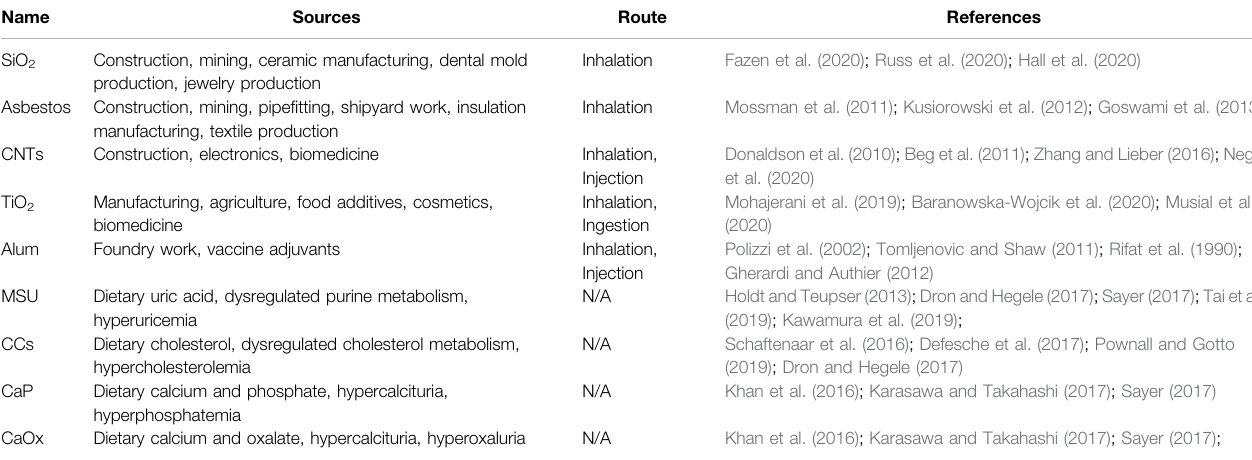
TABLE 1 | Sources and common exposure routes of exogenous and endogenous particles.